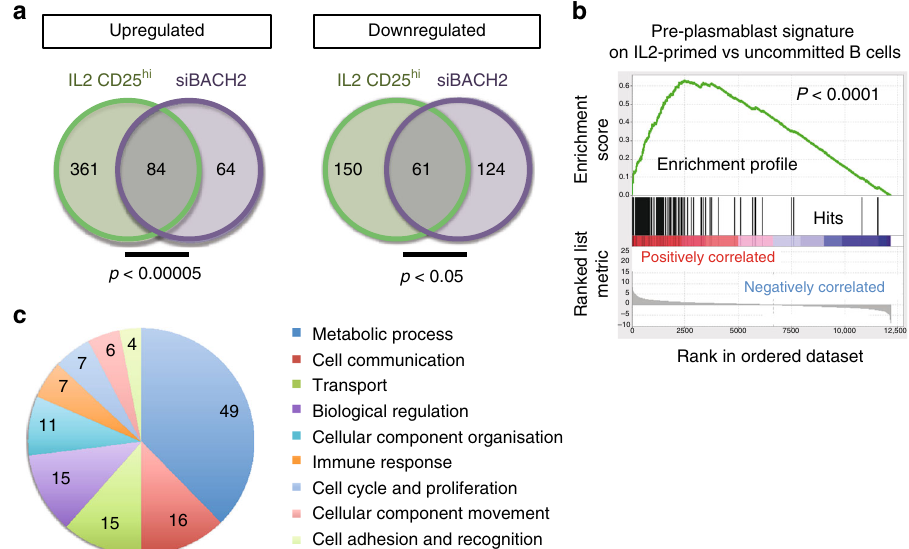
Fig. 5 siBACH2-committed cells share an extensive transcriptional program with IL-2 primed cells. a Expression pro fi les of committed cells through IL-2 priming (IL2 CD25 hi , sorted at D4 based on CFSE lo and CD25 hi expression, in green) or through BACH2 transient inhibition (siBACH2 CFSE lo cells sorted at D4, in purple). They were determined by RNA sequencing ( n = 3 per condition) and compared to uncommitted cells (CFSE lo cells that were cultured in absence of IL-2). A list of 445 and 211 genes that were, respectively, upregulated or downregulated after IL-2 priming were compared with the 148 and 185 genes that were, respectively, over- or under-expressed in siBACH2 compared with control cells (with a FC > 1.4 and p.adj < 0.05, Wald test) to generate Venn diagrams. The numbers of genes that are in common in both lists are indicated at the intersection between two circles. Hypergeometric distribution was used to calculate the p -value according to GSEA. b Gene set enrichment plot for genes highly expressed in preplasmablasts in the comparison between D4 IL-2-committed B cells and uncommitted B cells. c Functional analysis of upregulated genes in the BACH2 signature with the PANTHER classi fi cation system. The numbers of genes in each functional category are